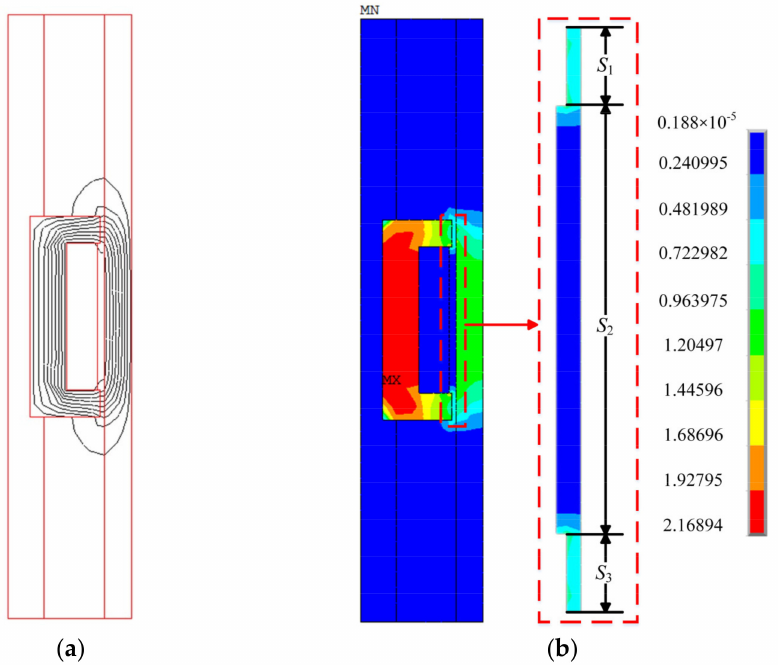
Figure 8. Magnetic field distribution inside a self-powered MR damper. ( a ) Magnetic line distribution. ( b ) Magnetic induction intensity cloud